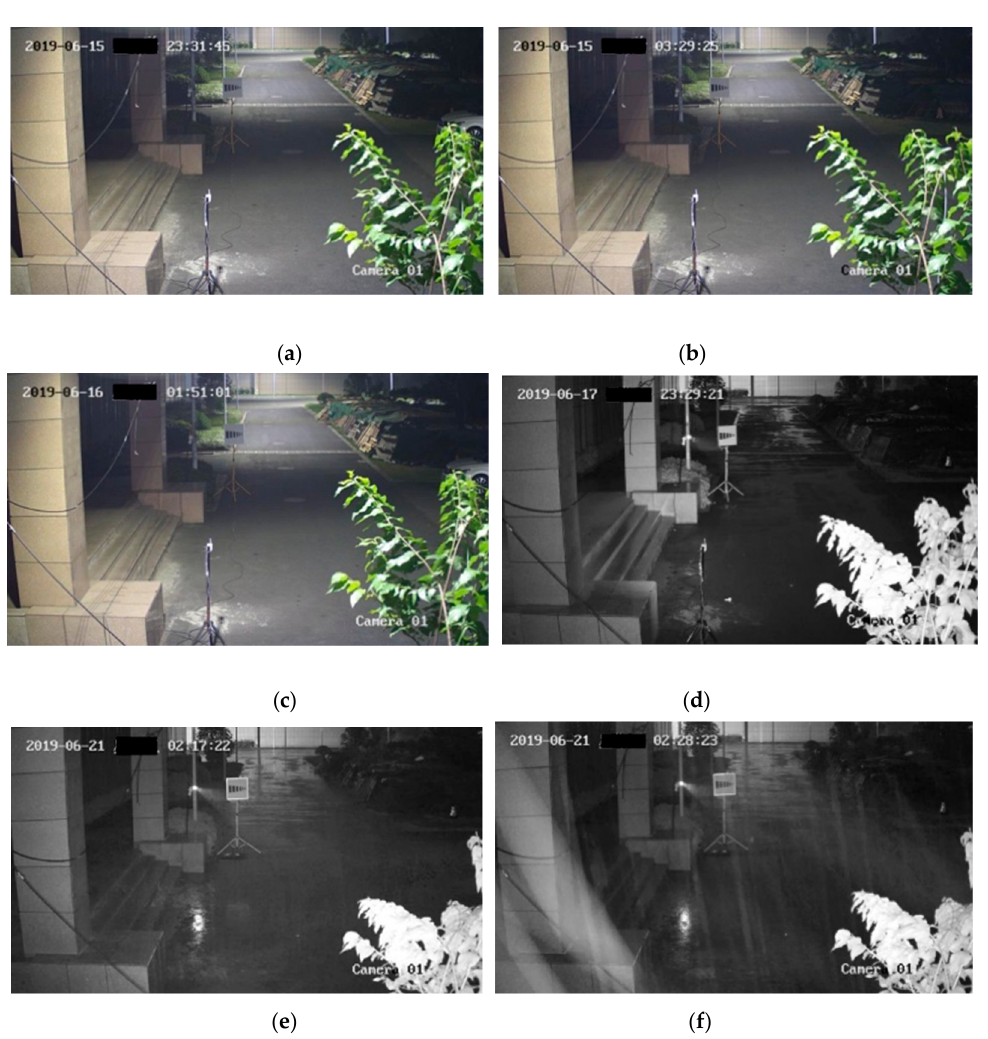
Figure 8. Samples of different visibility representative images acquired in actual measurements. The measured values are ( a ) 10,000 m, ( b ) 8007 m, ( c ) 5181 m, ( d ) 2250 m, ( e ) 861 m, ( f ) 177 m. Table 4. Estimated results of the images in Figure 8.